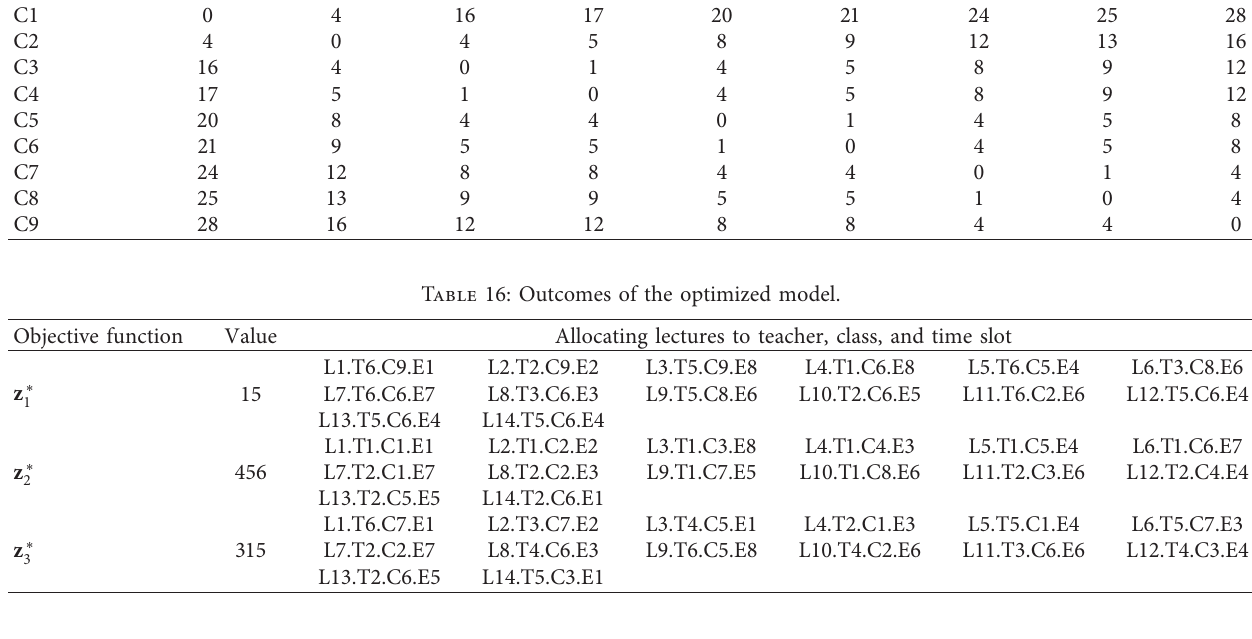
Table 17: Payoff table for three objective functions.